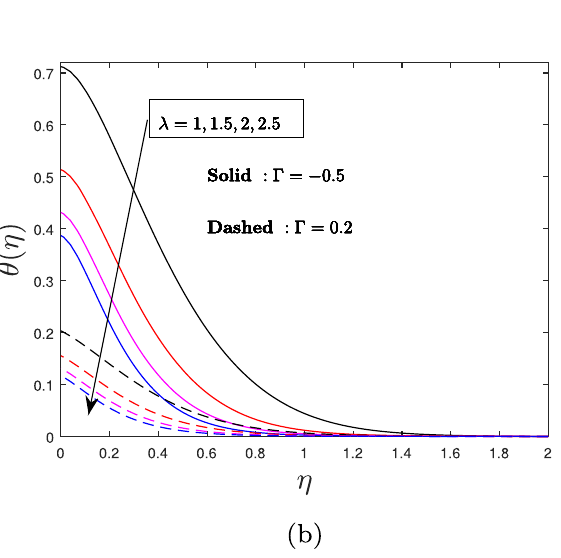
Figure 10: ( a ) Velocity and ( b ) thermal fi elds against di ff erent Λ .